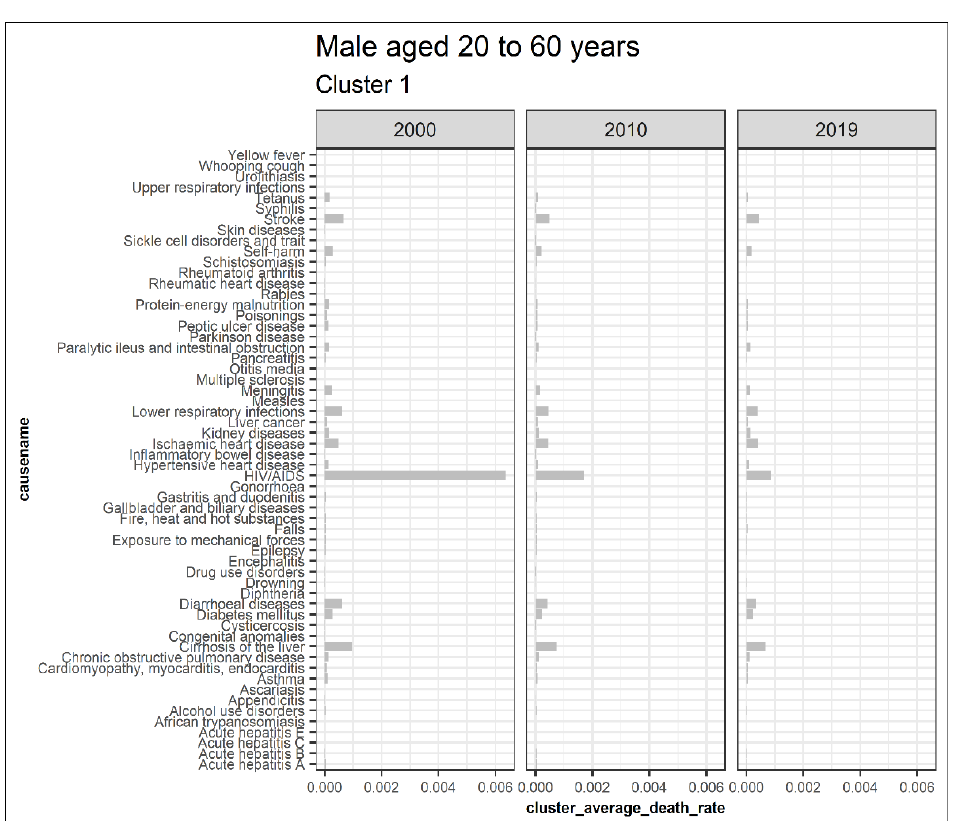
Figure 15. Declining trend causes among younger males in cluster 1 for 2000, 2010, and 2019.